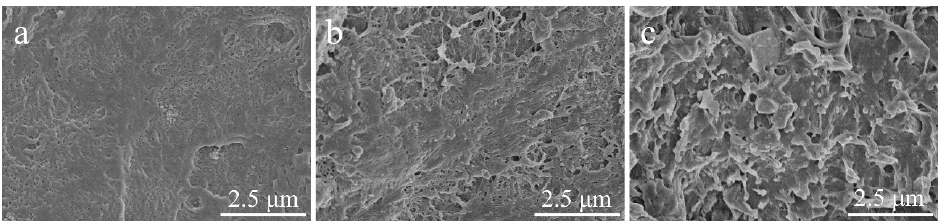
Figure 6. SEM images of HDPE composites’ brittle fracture surfaces: ( a ) 1.5ARHA/PE, ( b ) 5ARHA/PE, and ( c ) 15ARHA/PE.